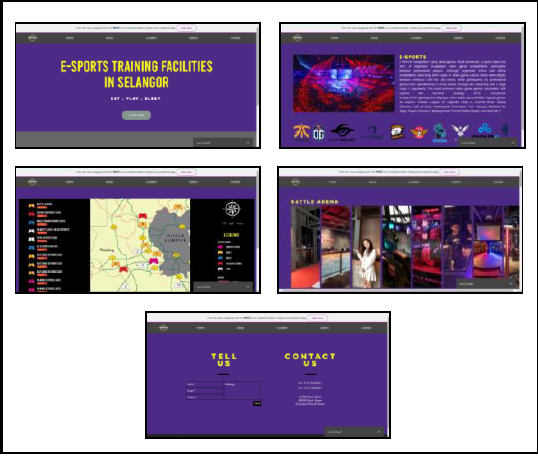
Figure 1. E-sports system created by using Wix